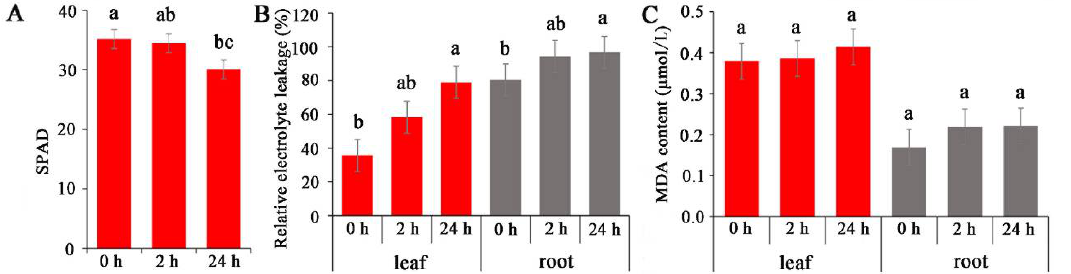
Figure 1. Analysis of dynamic physiological effects under NaCl stress. ( A ) Chlorophyll content. ( B ) Electrolyte leakage. ( C ) MDA (Malonydialdehyde) content. The results are the means and SDs of three replicates. The different letters above the bars indicate significant differences at the 0.05 level according to Duncan’s multiple range test.